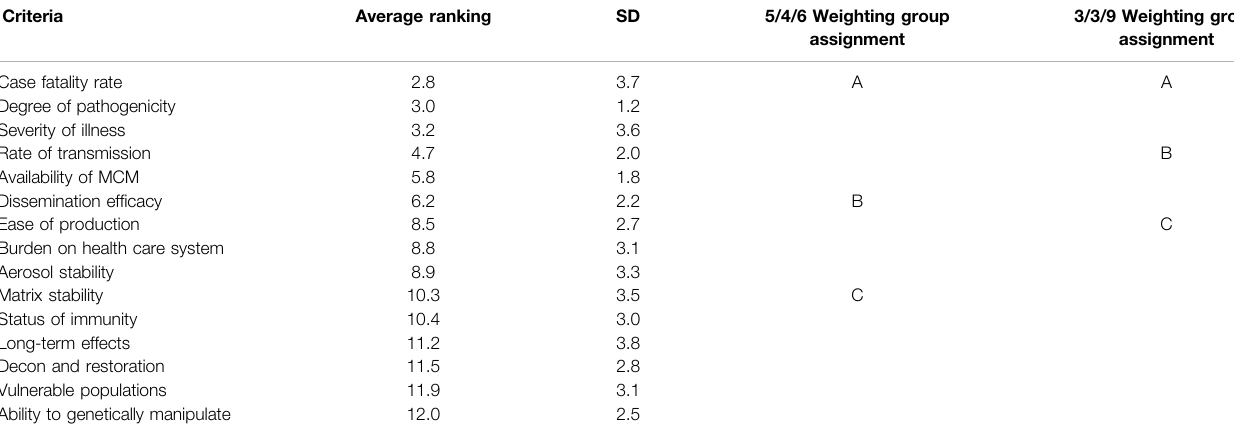
TABLE 2 | Criteria rank ordering by SMEs and assignment to one of three weighting groups (A, B or C).